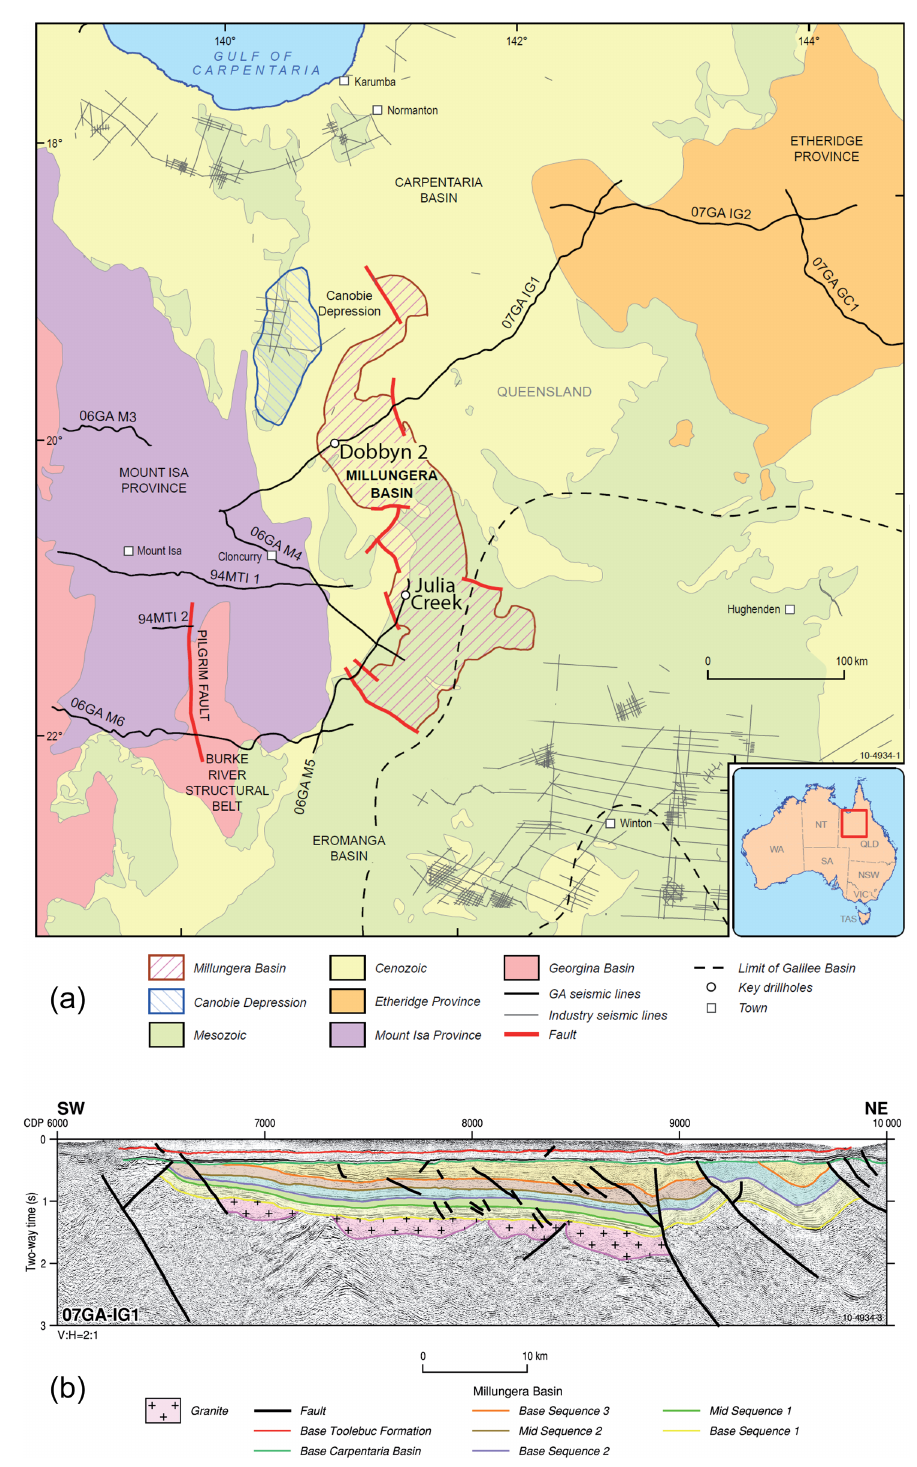
Figure 1. (a) Simplified map of north-central Australia showing the interpreted subsurface distribution of the Millungera Basin. The surface distribution of Cenozoic and Mesozoic sediments and the locations of the Proterozoic–Ordovician basins are also shown (modified from Korsch et al., 2011). (b) Interpreted migrated seismic section for part of seismic line 07GA-IG1 across the Millungera Basin, showing interpreted structures and sequence boundaries below the base Carpentaria unconformity (from Korsch et al.,